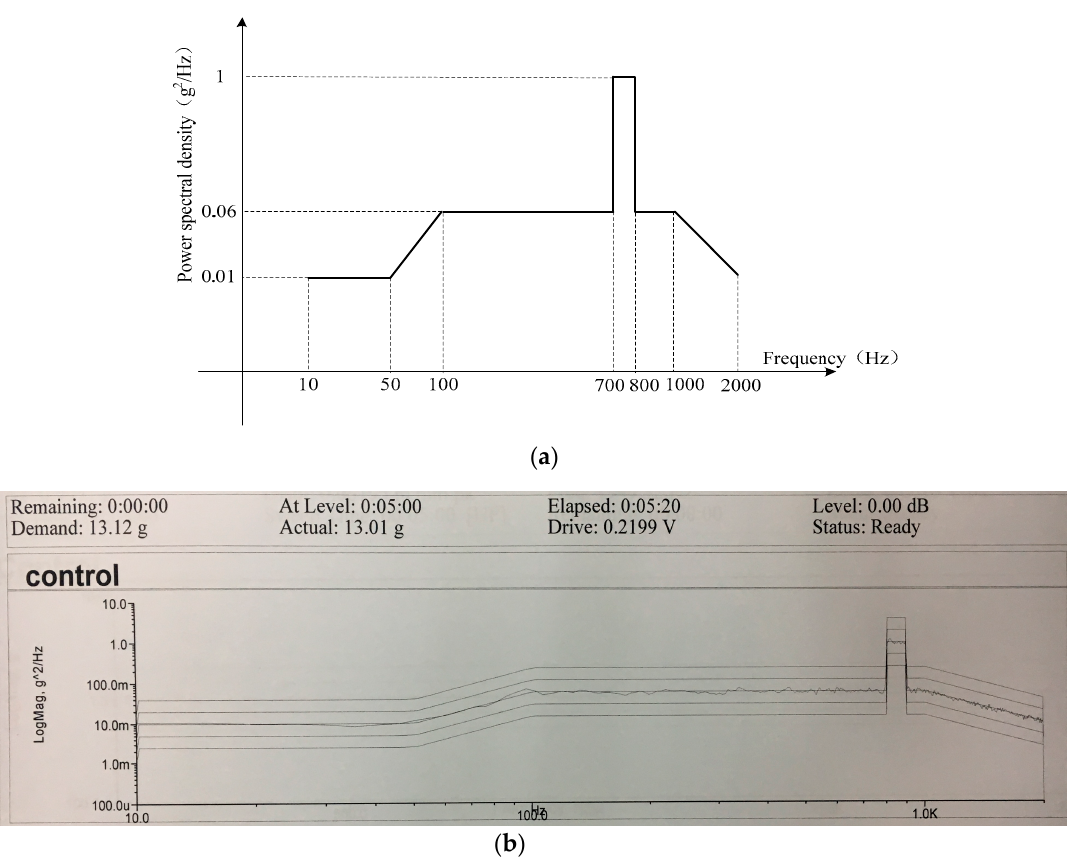
Figure 2. power spectral density (PSD) of the random vibration. ( a ) PSD of the vibration; ( b ) the output of the vibration table.